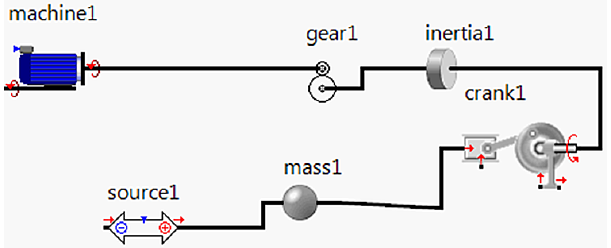
Figure 2. Dynamic model of machine with slider-crank mechanism on